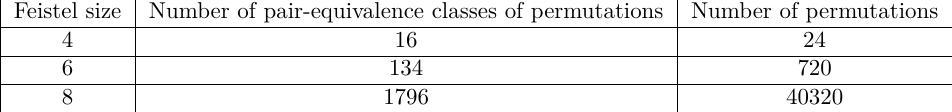
Table 2: Comparison between numbers of classes and total numbers of permutations Feistel size Number of pair-equivalence classes of